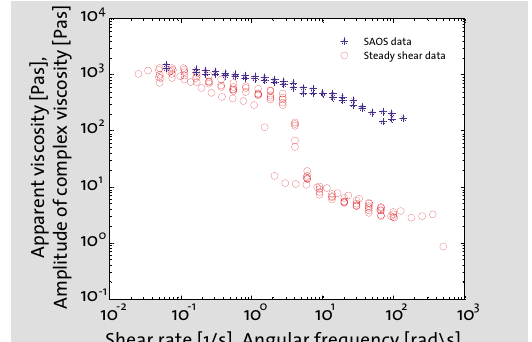
Figure 6 (left above): Steady shear flow and SAOS data for yogurt at 30˚C. Figure 7 (right above): Steady shear flow and SAOS data for Mozzarella cheese at 60˚C. Figure 8 (left below): Steady shear flow and SAOS data for Processed cheese at 60˚C.